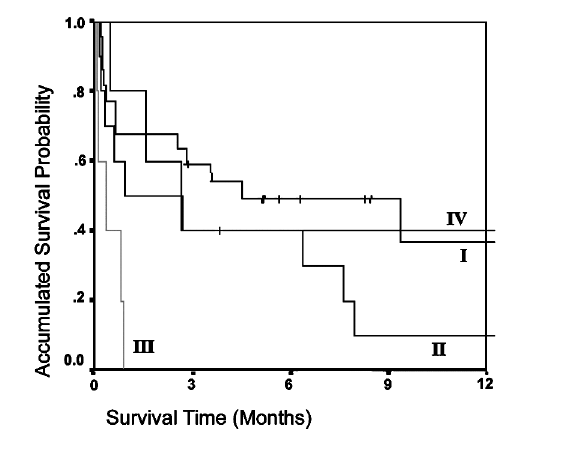
Figure 2 – Survival according to primary site of neoplasias (I = uterine cervix, II = bladder, III = prostate, IV = other sites, p =